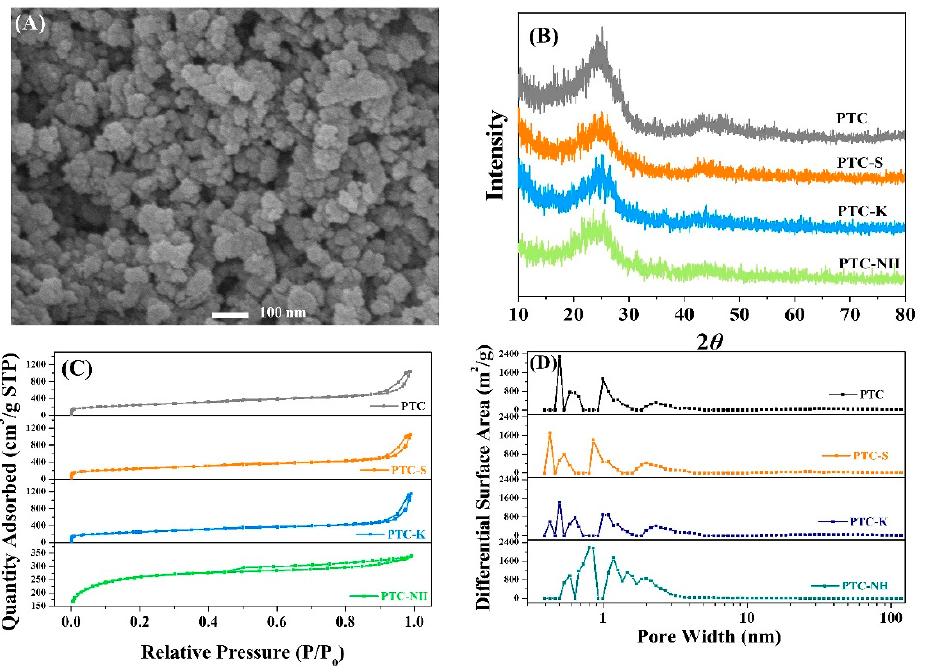
Figure 1. ( A ) SEM of PTC, ( B ) XRD patterns, ( C ) N 2 adsorption isotherms, and ( D ) pore size distributions of the PTC, PTC-S, PTC-K, and PTC-NH supports. Table 1. The surface structural properties of the PTC, PTC-S, PTC-K, and PTC-NH supports. Supports Surface Area (m 2 /g)